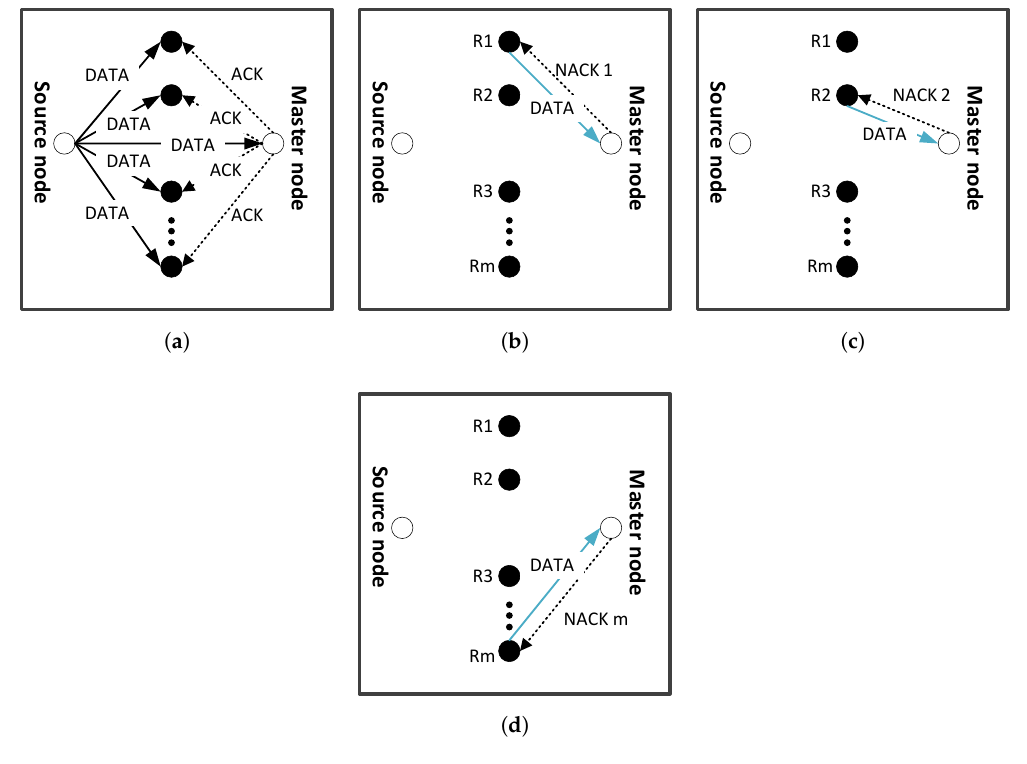
Figure 6. Data transmission from source to master node: ( a ) packet is accepted by master node and acknowledgement (ACK) is sent to retransmission nodes indicating that no retransmission is required; ( b ) packet is rejected by master node and asking for first retransmission from R1; ( c ) packet is again rejected and asking for second retransmission from R2; and ( d ) m th relay node performing data